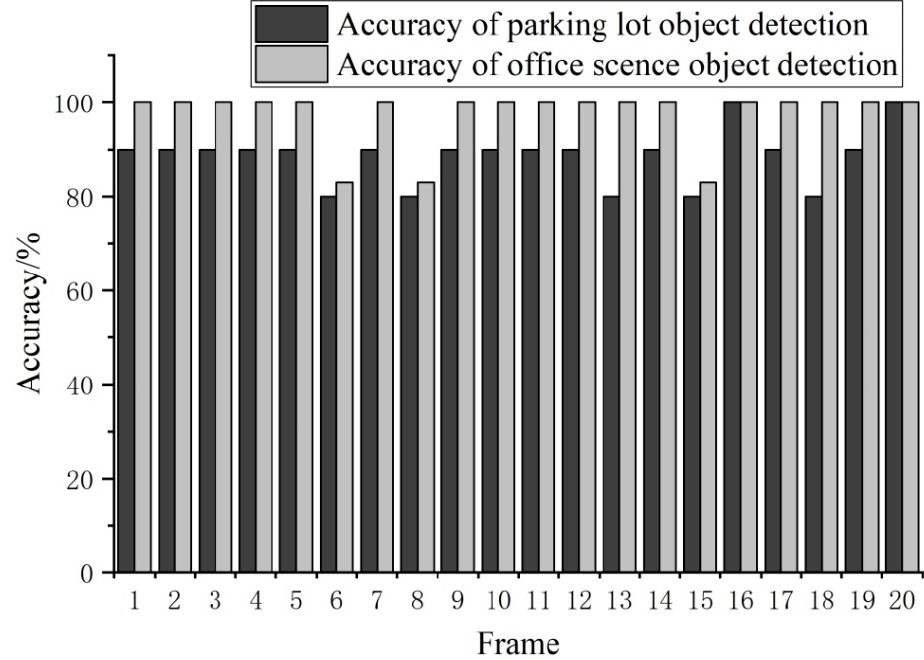
Figure 10. The object detection accuracy in different scenarios. In the office, Camera 1 selected eight experimental points, and Camera 2 selected seven experimental points. In the parking lot, Camera 3 selected nine experimental points, and Camera 4 selected eight experimental points. These object points were numbered in order. We set the geographic coordinates of the seat center and car center in the 2D map to the true values. For the experimental points, we calculated their mapping coordinates through the traditional homography matrix method and the HP-HM method. ∆ t represents the offset of the calculated value and true value, as shown in Equation (11). ∆ x is the difference between the x coordinates of two points. ∆ y is the y difference.